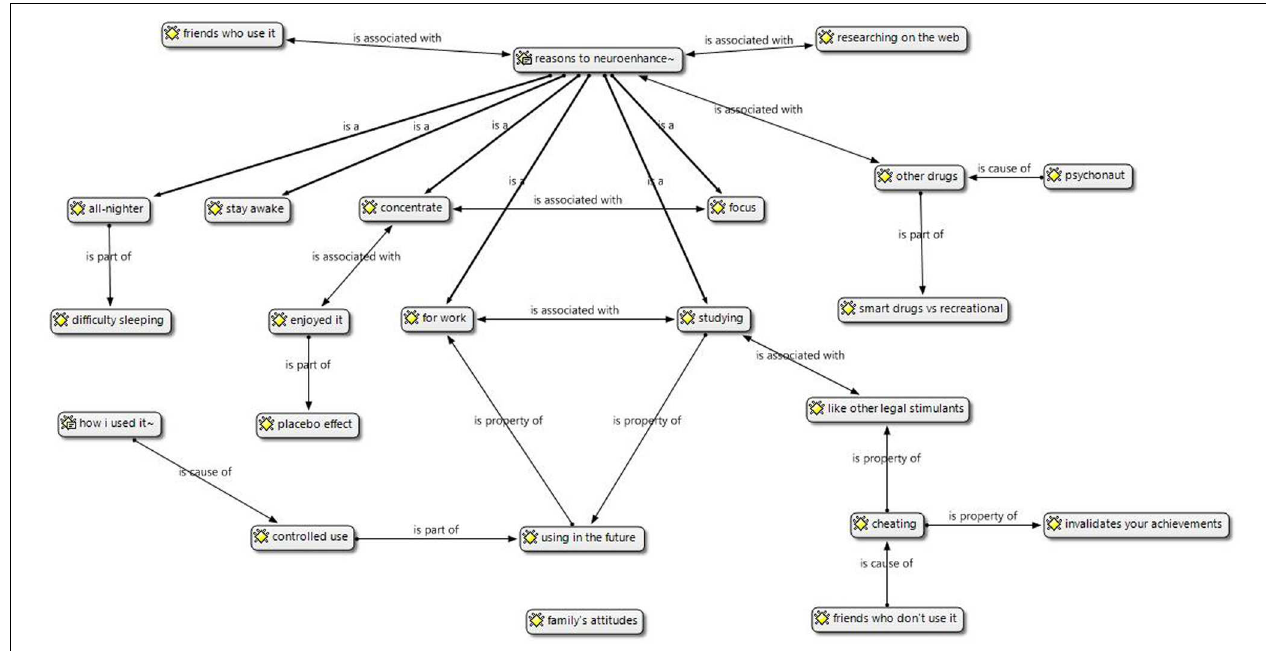
FIGURE 2 | Conceptual map depicting the sample’s storyline. Nodes represent the most relevant codes according to groundedness and centrality in the interpretative process. Links represent relationships between